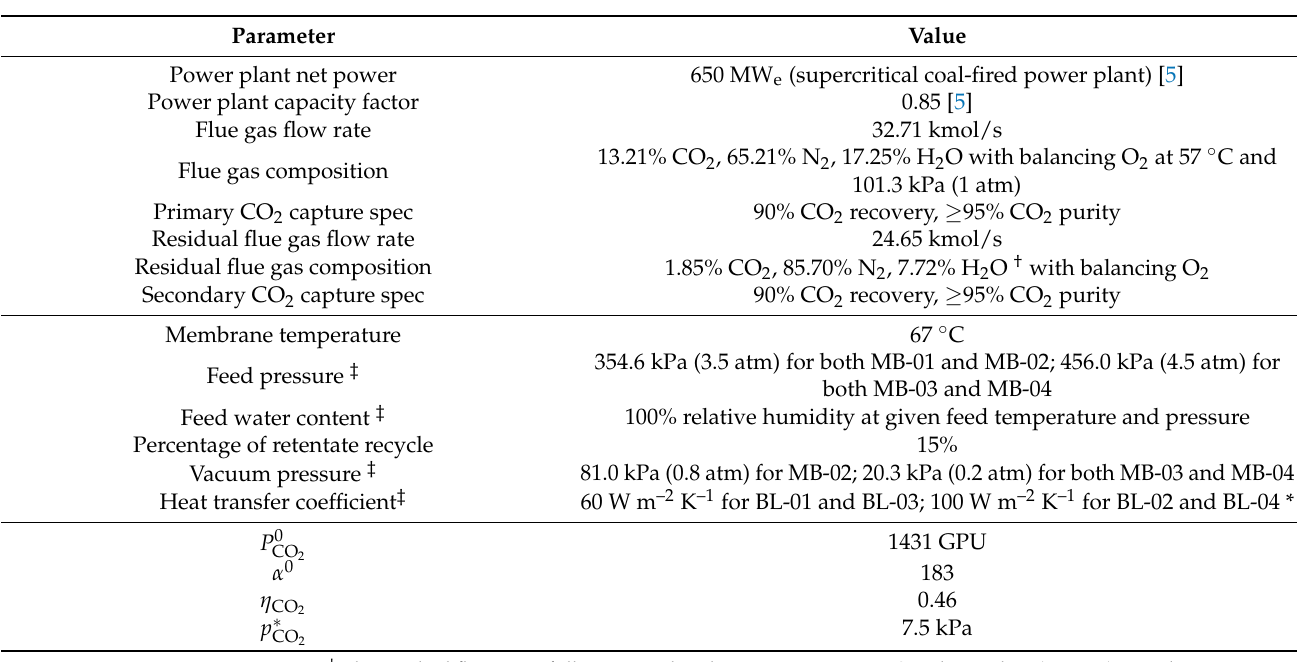
Table 1. Key plant operating